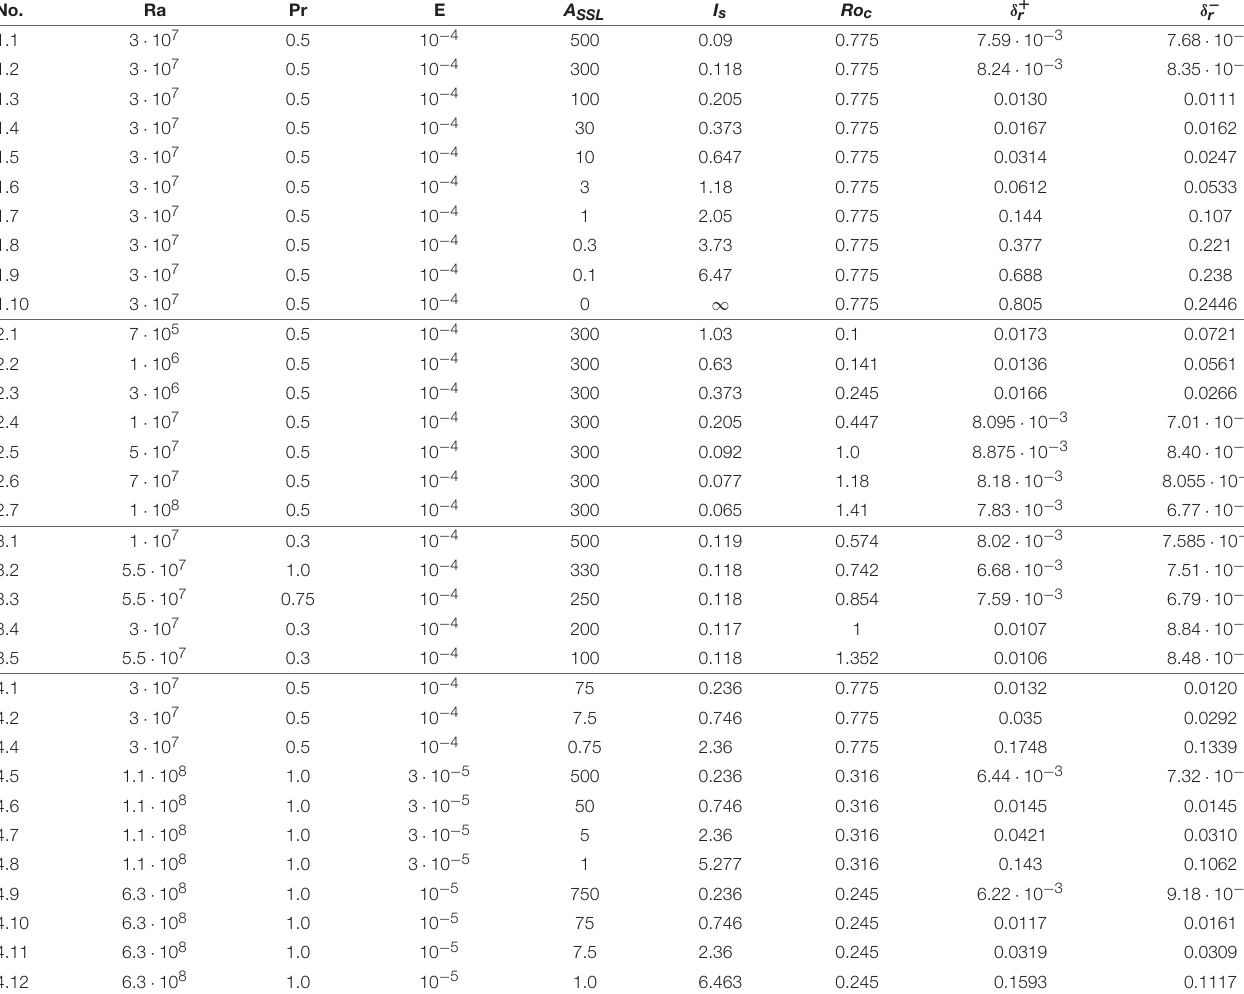
Figure 2 , left plot scatters the models over their associated time scale ratios, i.e., Ro c and I s .